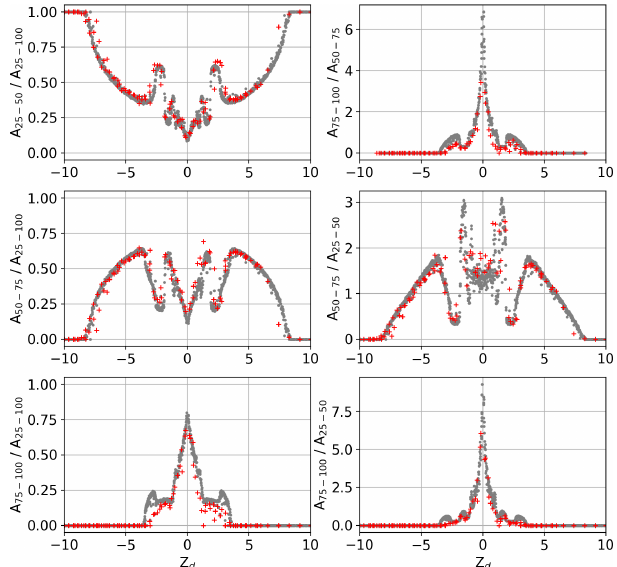
Figure 7. The ratios of the number of pixels between different thresholds from the drop generator experiments (red) and model simulations of particles in the size range 50 to 150µm (grey) as a function of normalised distance from the object plane ( Z d ).